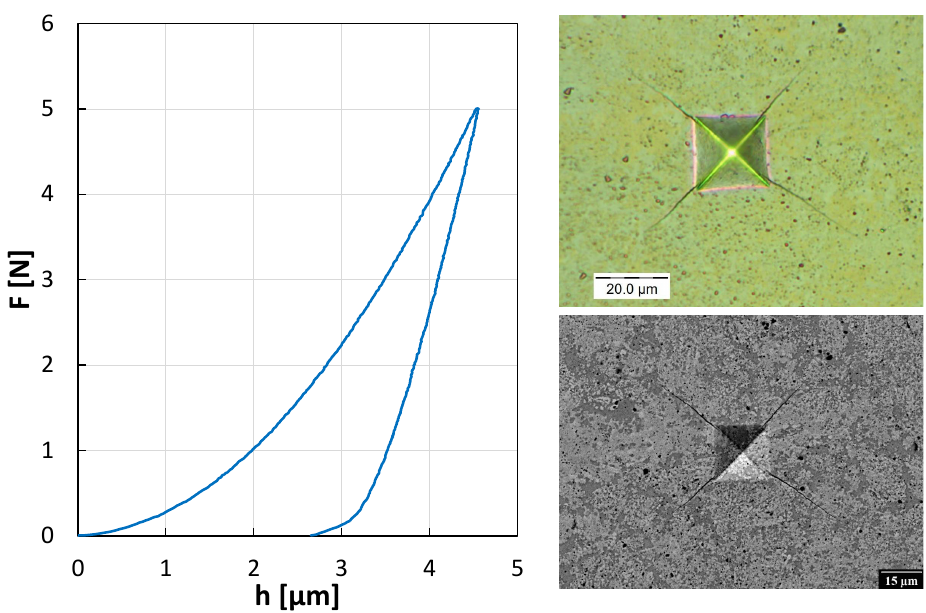
Figure 2. Indentation curve and the residual indent with Palmqvist cracks in Fe_Al_Si sample. No lateral cracks were observed on micrographs from light optical microscope or SEM.